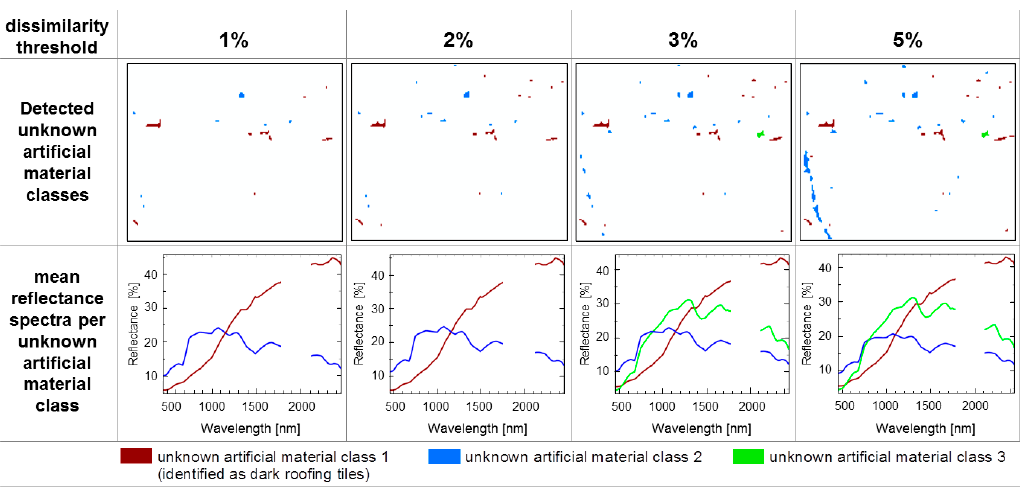
Figure 7. Impact of an increasing dissimilarity threshold on the number of detected unknown artificial material classes elucidated for test site C with a BSL without tiles.